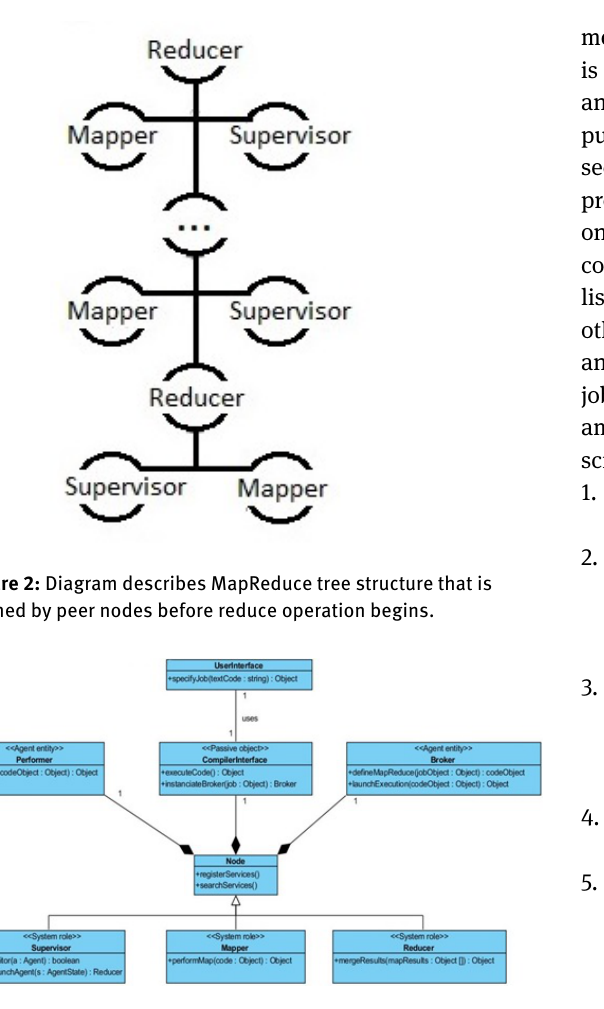
Figure 3: UML Class Diagram describing nodes com- posite struc- ture, their roles and relationship with user